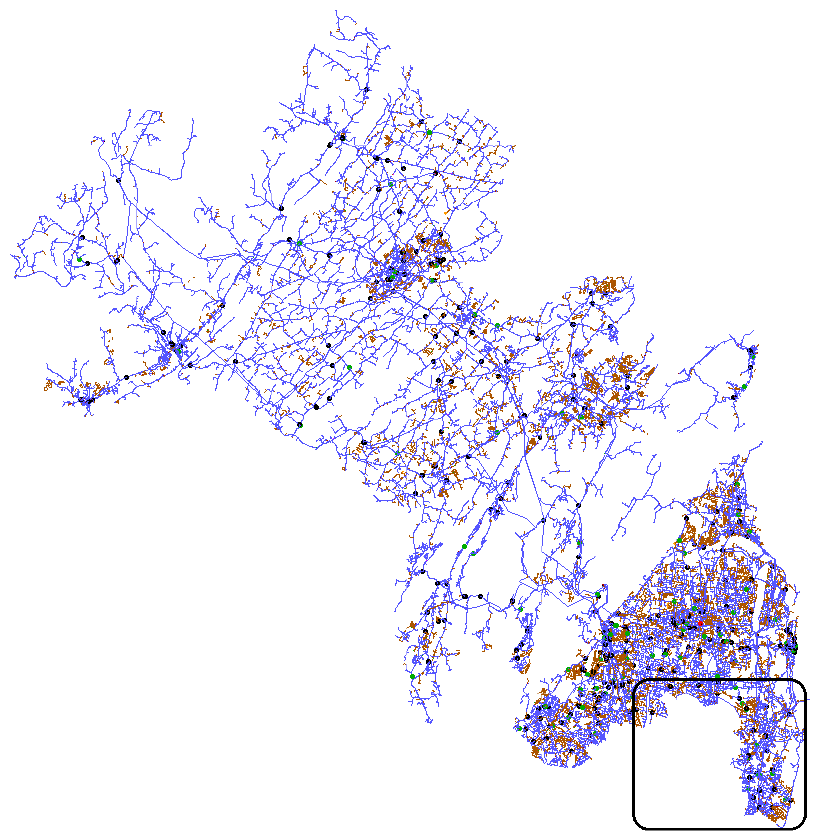
Figure 2. Model consisting of eight voltage levels—components with least stability margin lie in the highlighted area.